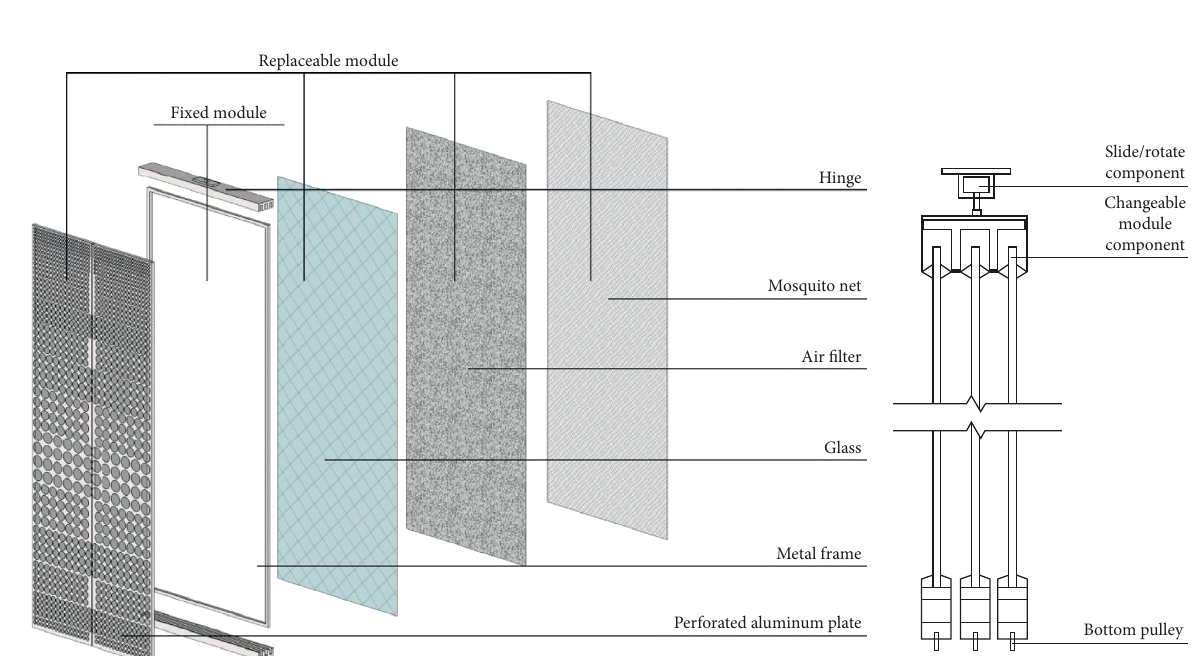
Figure 15: Replaceable modules based on climate adaptability (source: authors’ own